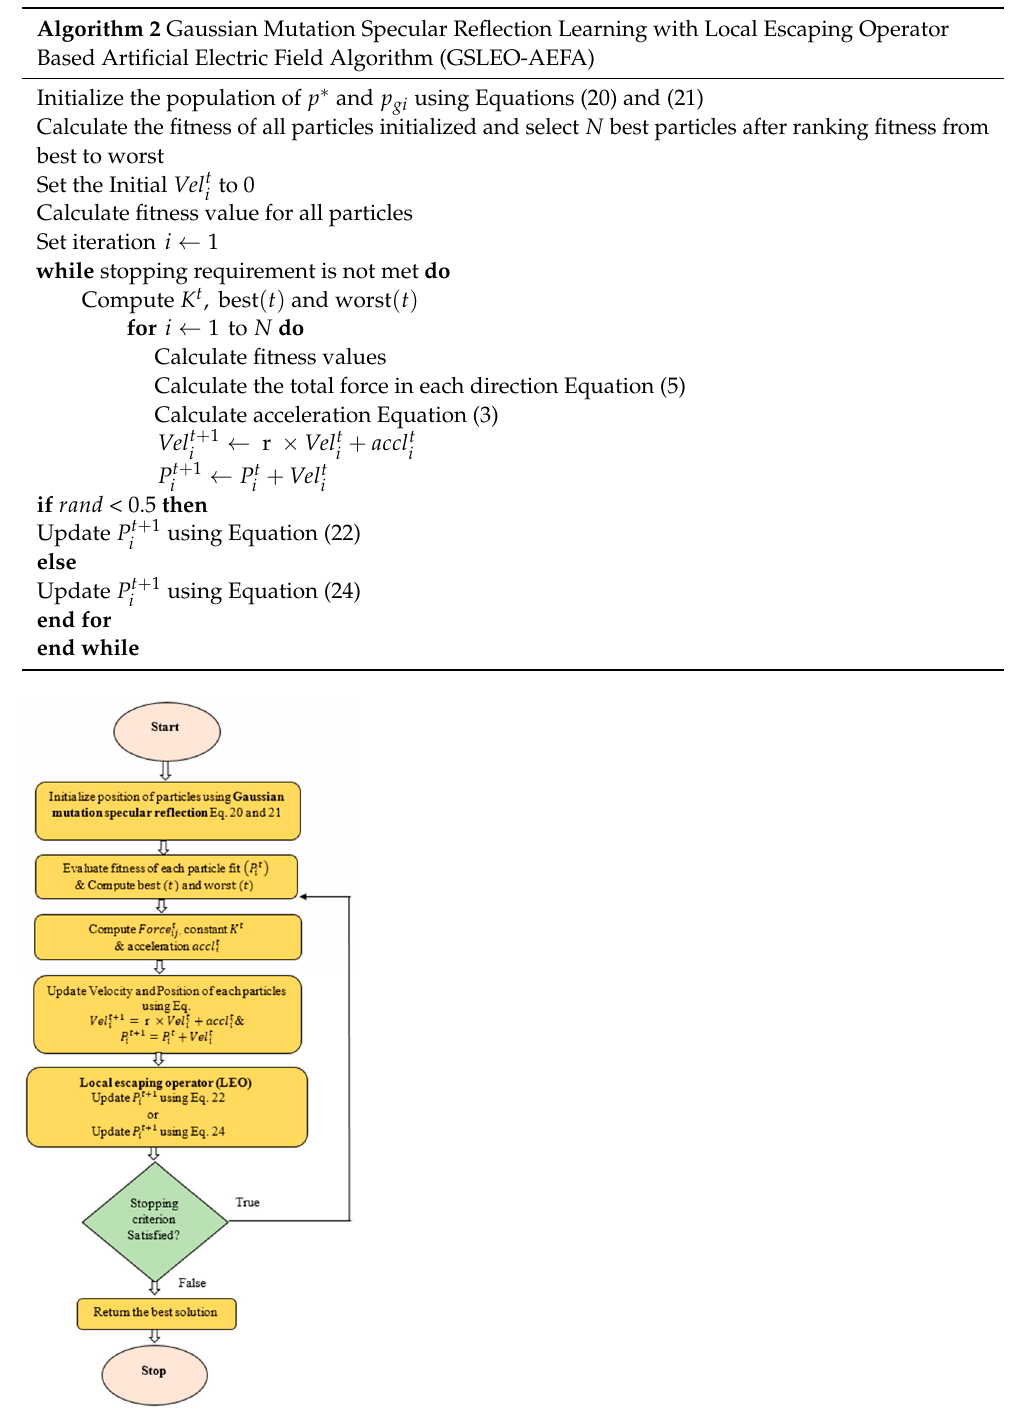
Figure 3. Flowchart of GSLEO-AEFA.